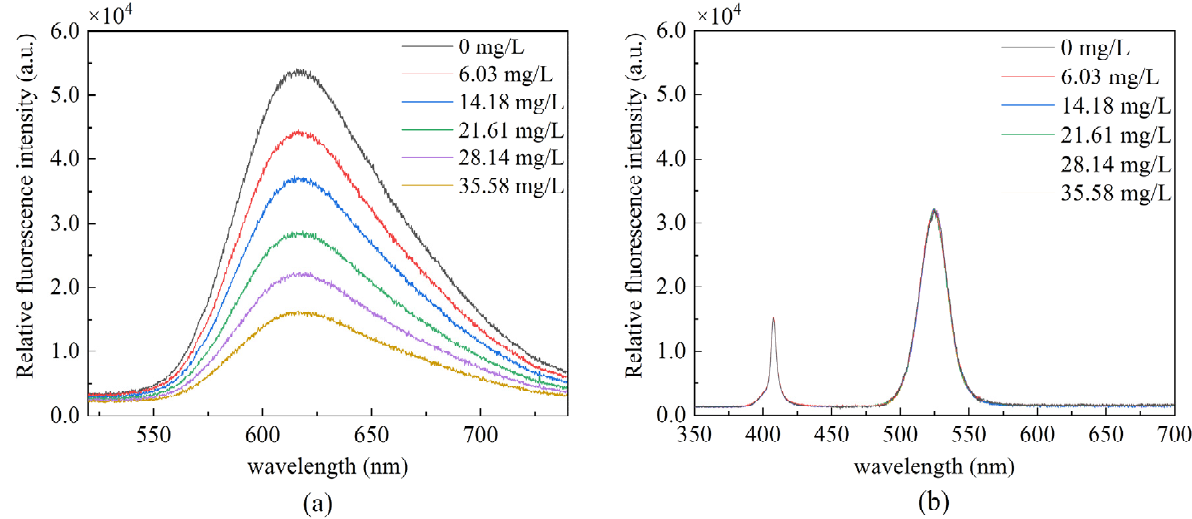
Figure 5. Fluorescence response in gaseous oxygen ( a ) ruthenium complex ( b ) QDs.